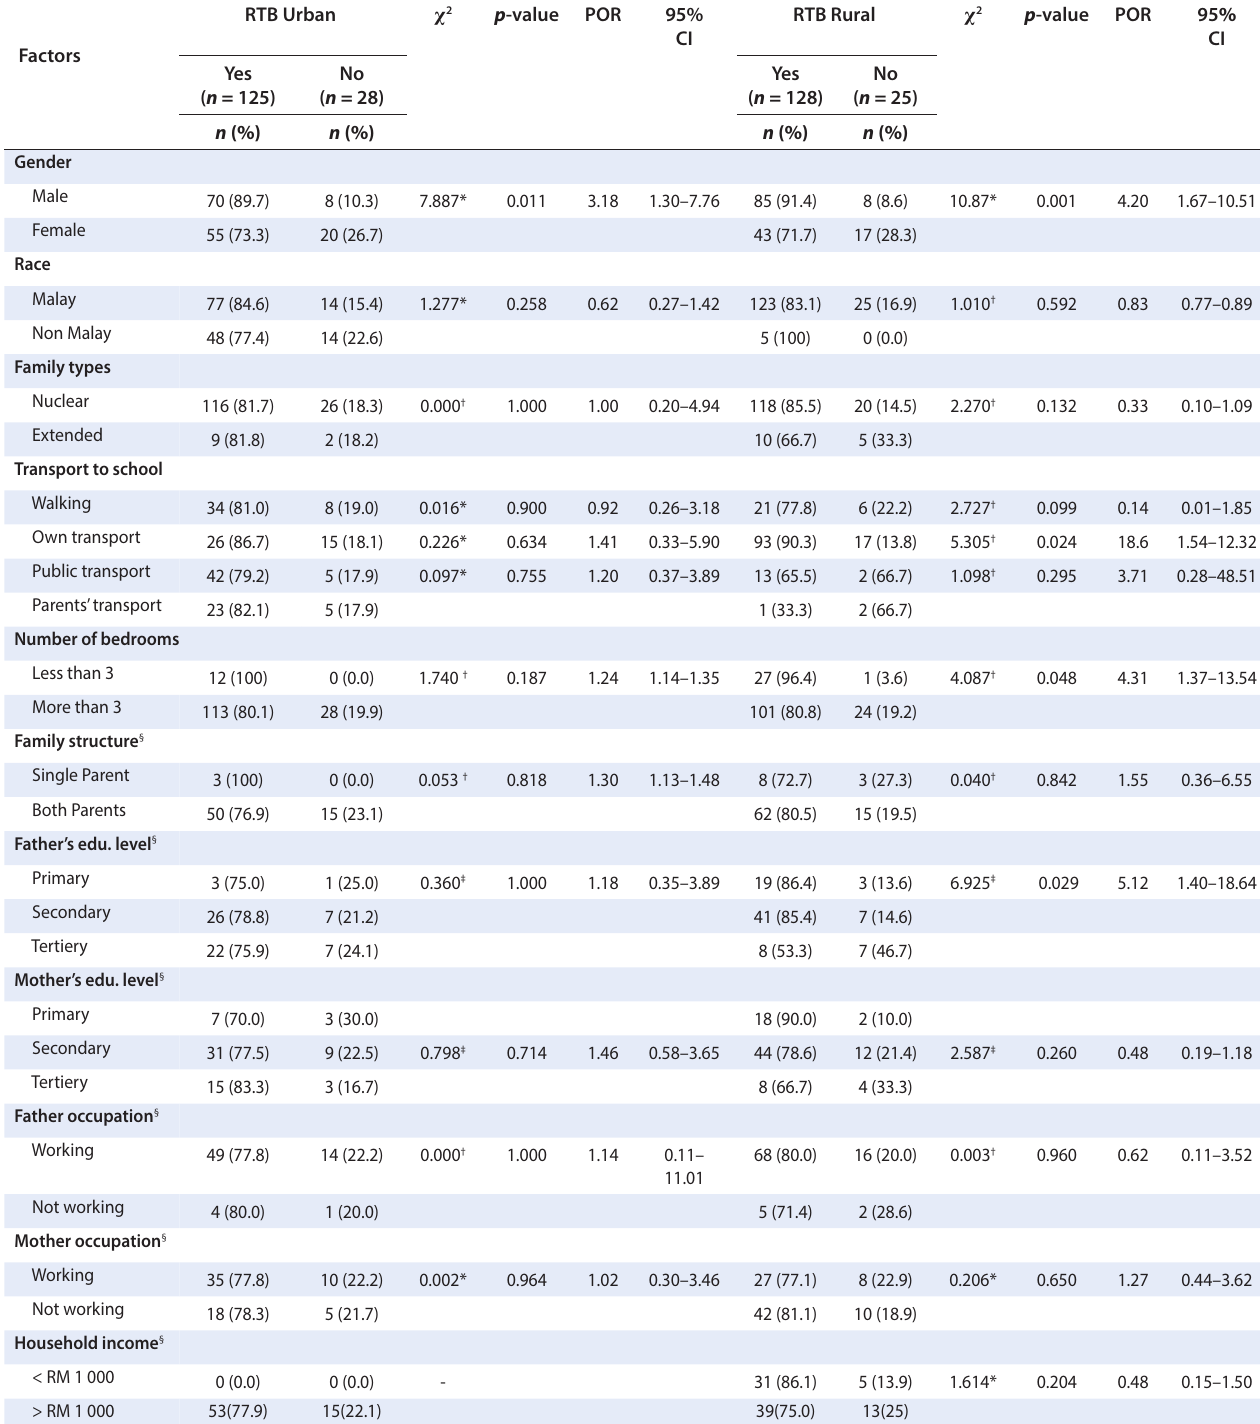
Table 2: Risk taking behaviour comparison between urban and rural adolescents